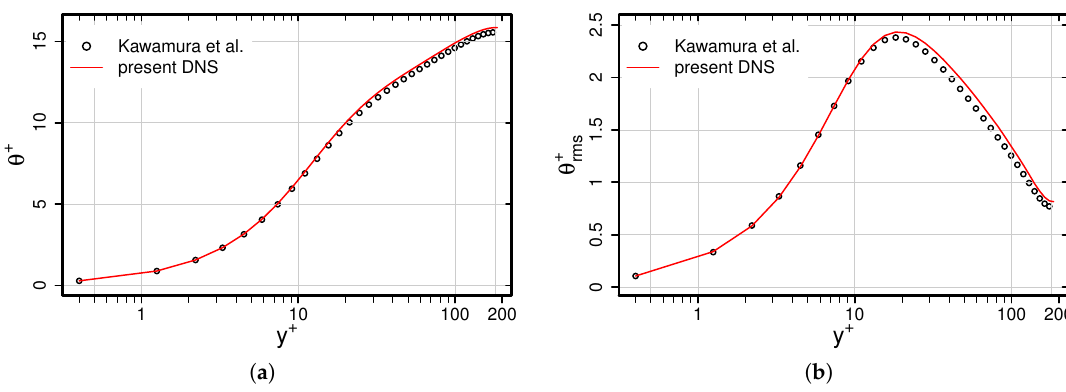
Figure A3. Mean ( a ) and RMS ( b ) temperature as a function of the non-dimensional wall distance y + . Comparison of results from the present DNS with the reference data of